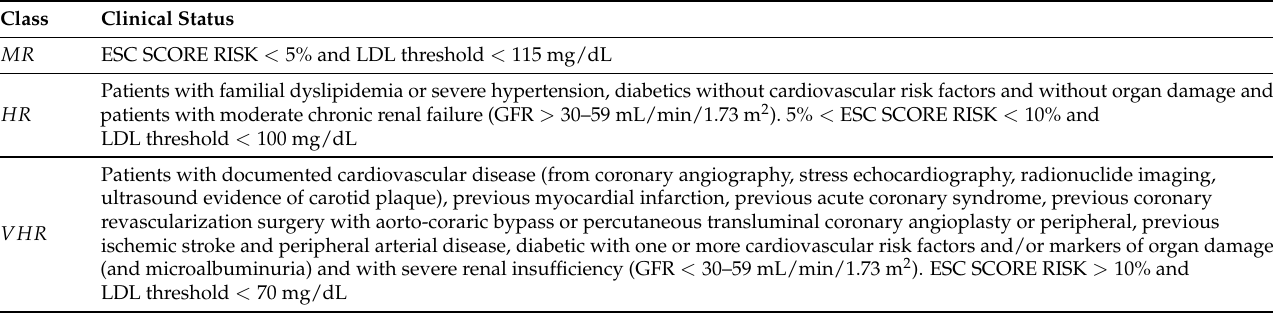
Table 2. Clinical conditions linked to the three considered classes. In particular each level risk is characterized by different values of ESC SCORE RISK [36] and low-density lipoproteins (LDL) cholesterol.